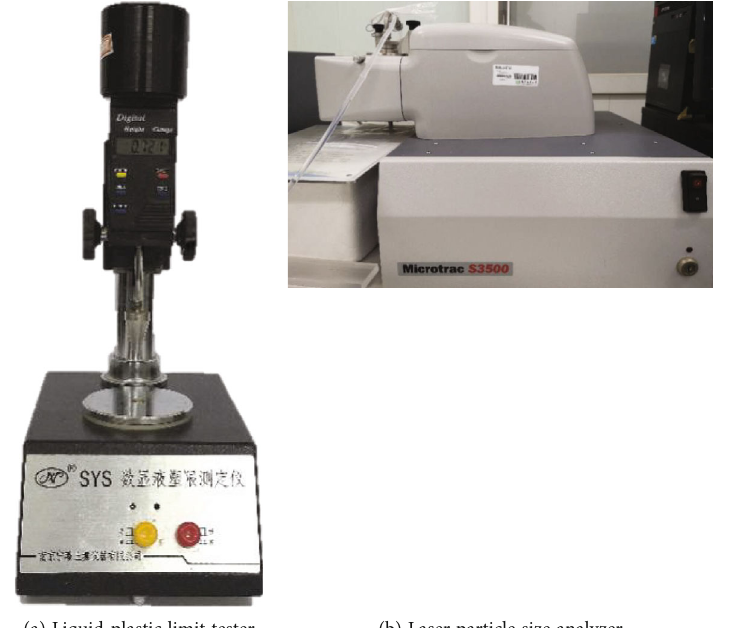
Figure 1: Soil property testing equipment.